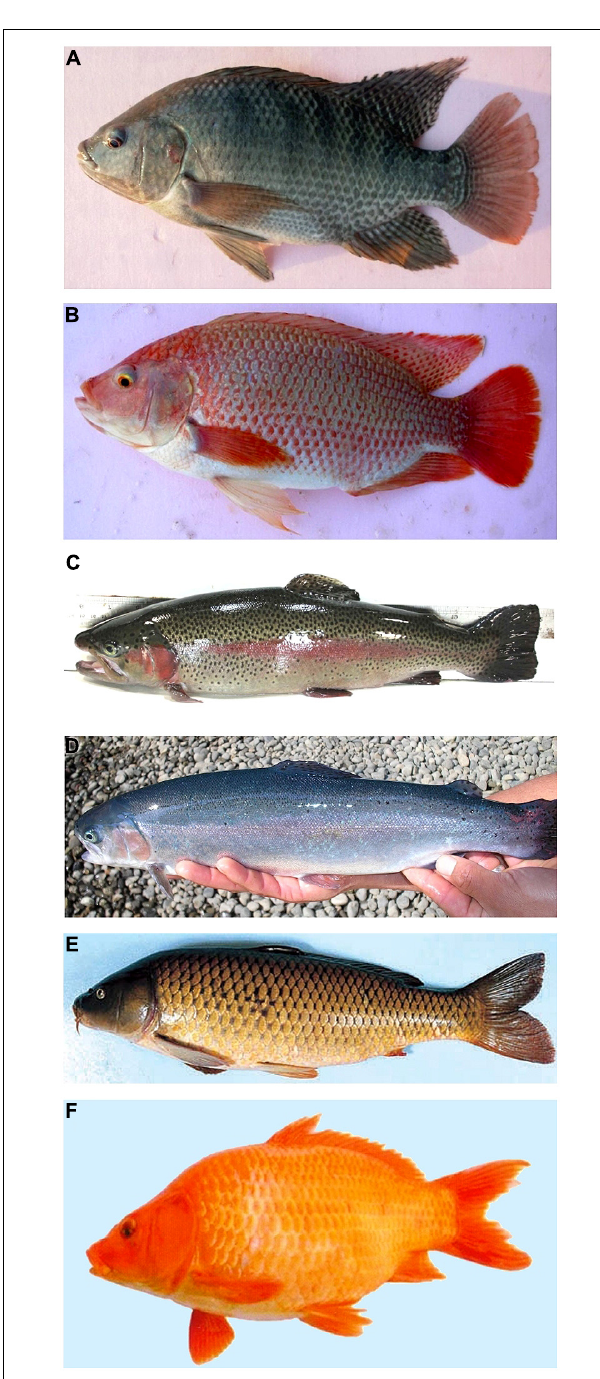
FIGURE 1 | Examples of commercial fish strains with improved skin pigmentation and body shape. (A) A wild-type tilapia ( Oreochromis niloticus ) with normal black pigmentation; (B) a red strain tilapia (red Yumbo) with improved red skin pigmentation; (C) a wild-type rainbow trout ( Oncorhynchus mykiss ) with normal pigmentation and (D) a Blue Back rainbow trout with improved intense bluish back, whitish belly, and a reduced number of dark spots; (E) a common carp ( Cyprinus carpio ) of var. haematopterus (or Amur wild carp) with a spindle-shaped body and steel-gray skin color; and (F) a common carp of var. wuyuanensis with improved broadly elliptical body (red skin